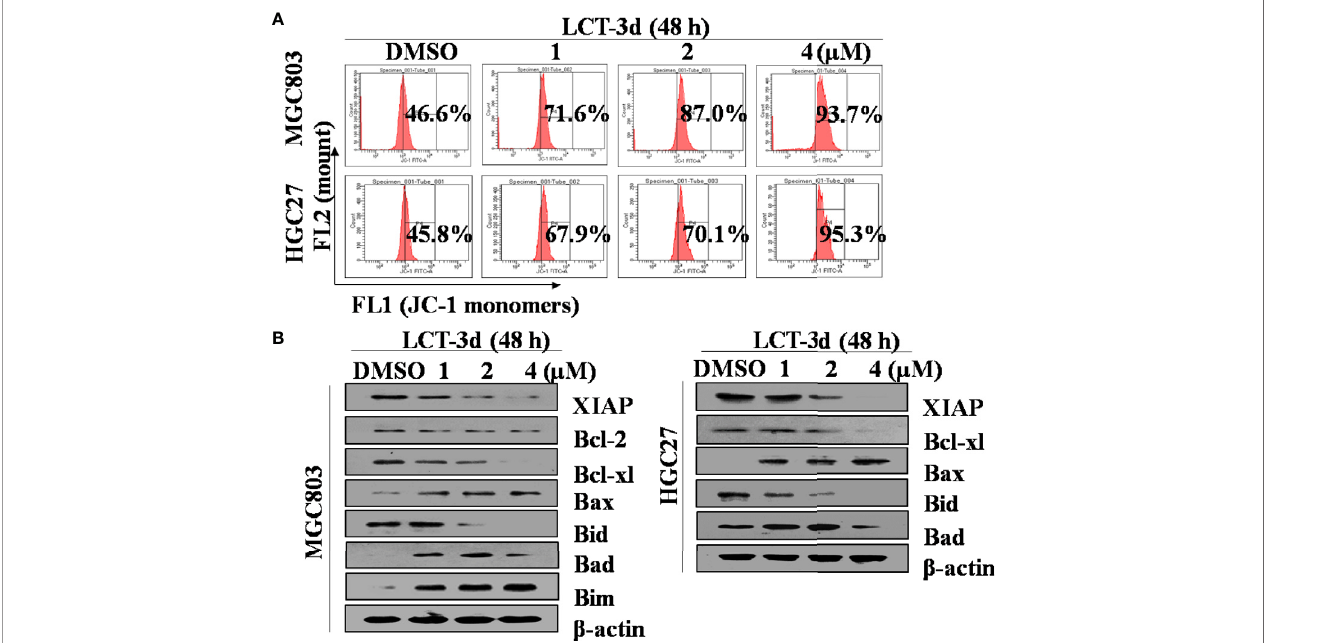
FIGURE 3 | LCT-3d-induced apoptosis was associated with mitochondrial pathway in gastric cancer cells. (A) MGC803 cells and HGC27 cells were treated with various concentrations of LCT-3d for 48 h and the membrane potential was measured by JC-1 dye retention using fl ow cytometry. (B) Cells were treated as in (A) and the expression of Bax, Bad, Bim, Bid, Bcl-xL, Bcl-2, and XIAP proteins was determined by Western blotting.